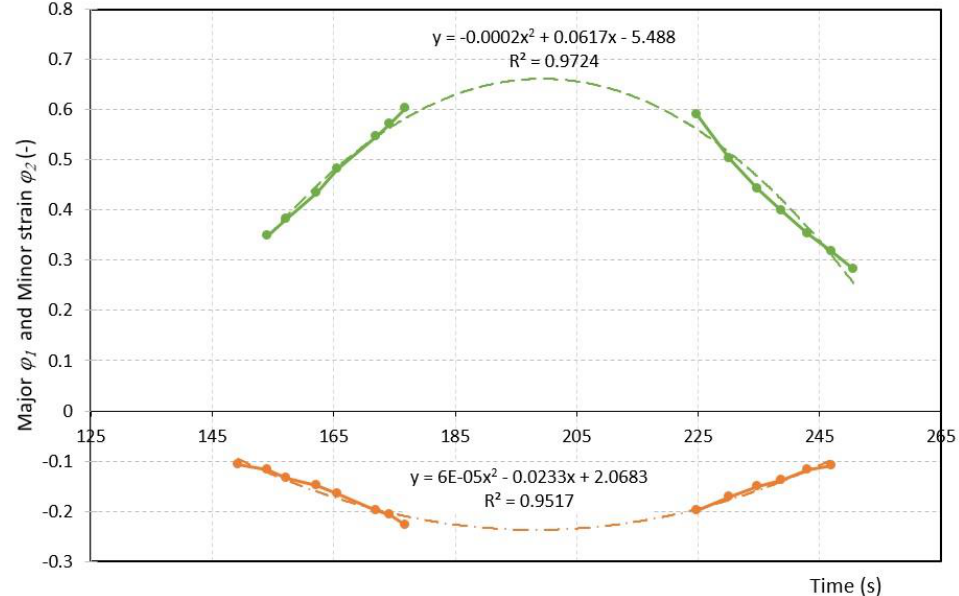
Figure 8. Dependence of the major and the minor strain on time without the filtered-out